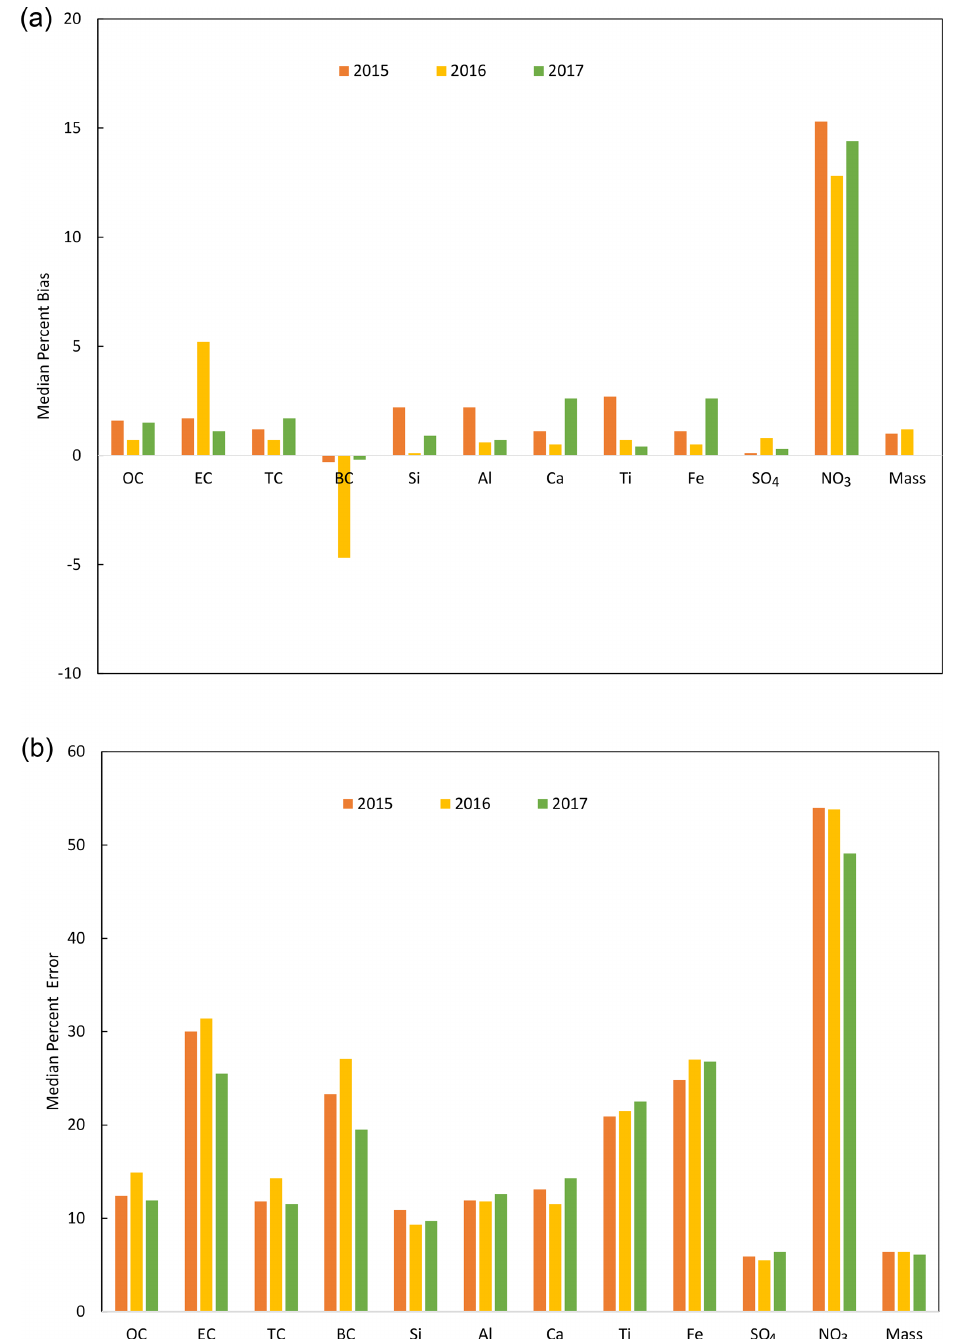
Figure 6. (a) Median percent bias and (b) median percent error for each constituent measured for each year.